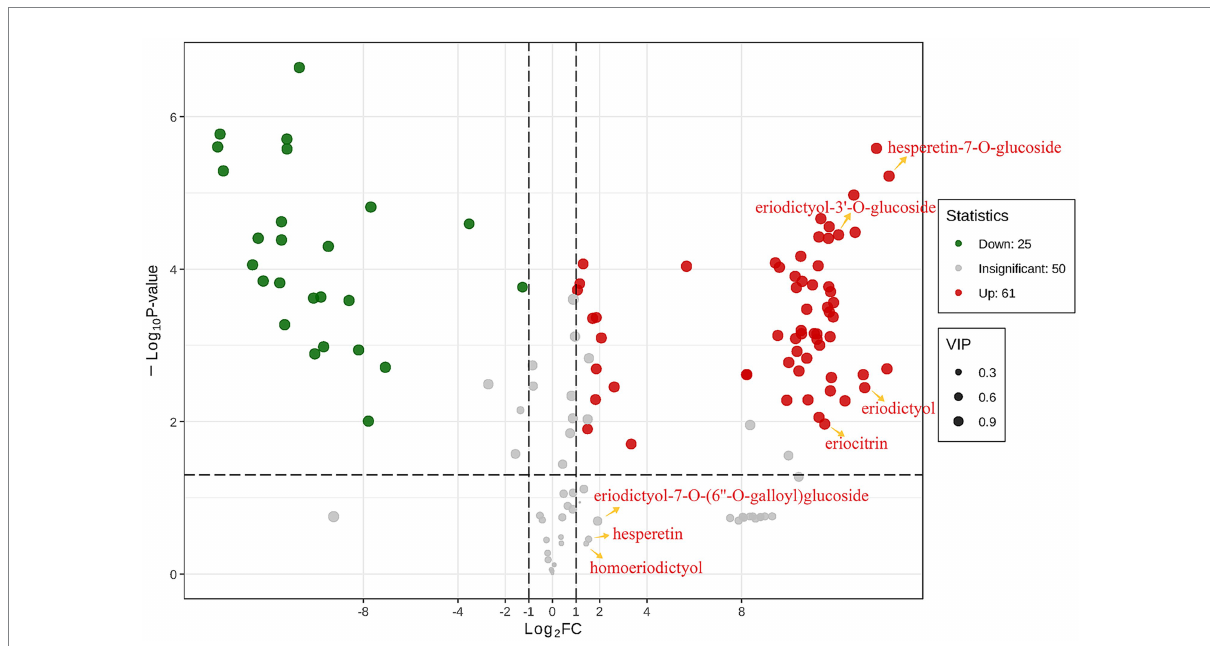
FIGURE 2 Differential metabolites analyses for control group vs. eriocitrin group by criteria set at FC ≥ 2 or ≤ 0.5, VIP ≥ 1 and p < 0.05. each point in the figure represents a metabolite, where red and green points represent up-regulated and down-regulated differential metabolites, respectively, and gray points represent metabolites that were detected but not significantly different. The abscissa represents the logarithm of the relative content difference of a metabolite in the two groups of samples (log 2 FC), the ordinate represents the significance level of the difference ( − log10P-value), and the size of the dot represents the VIP